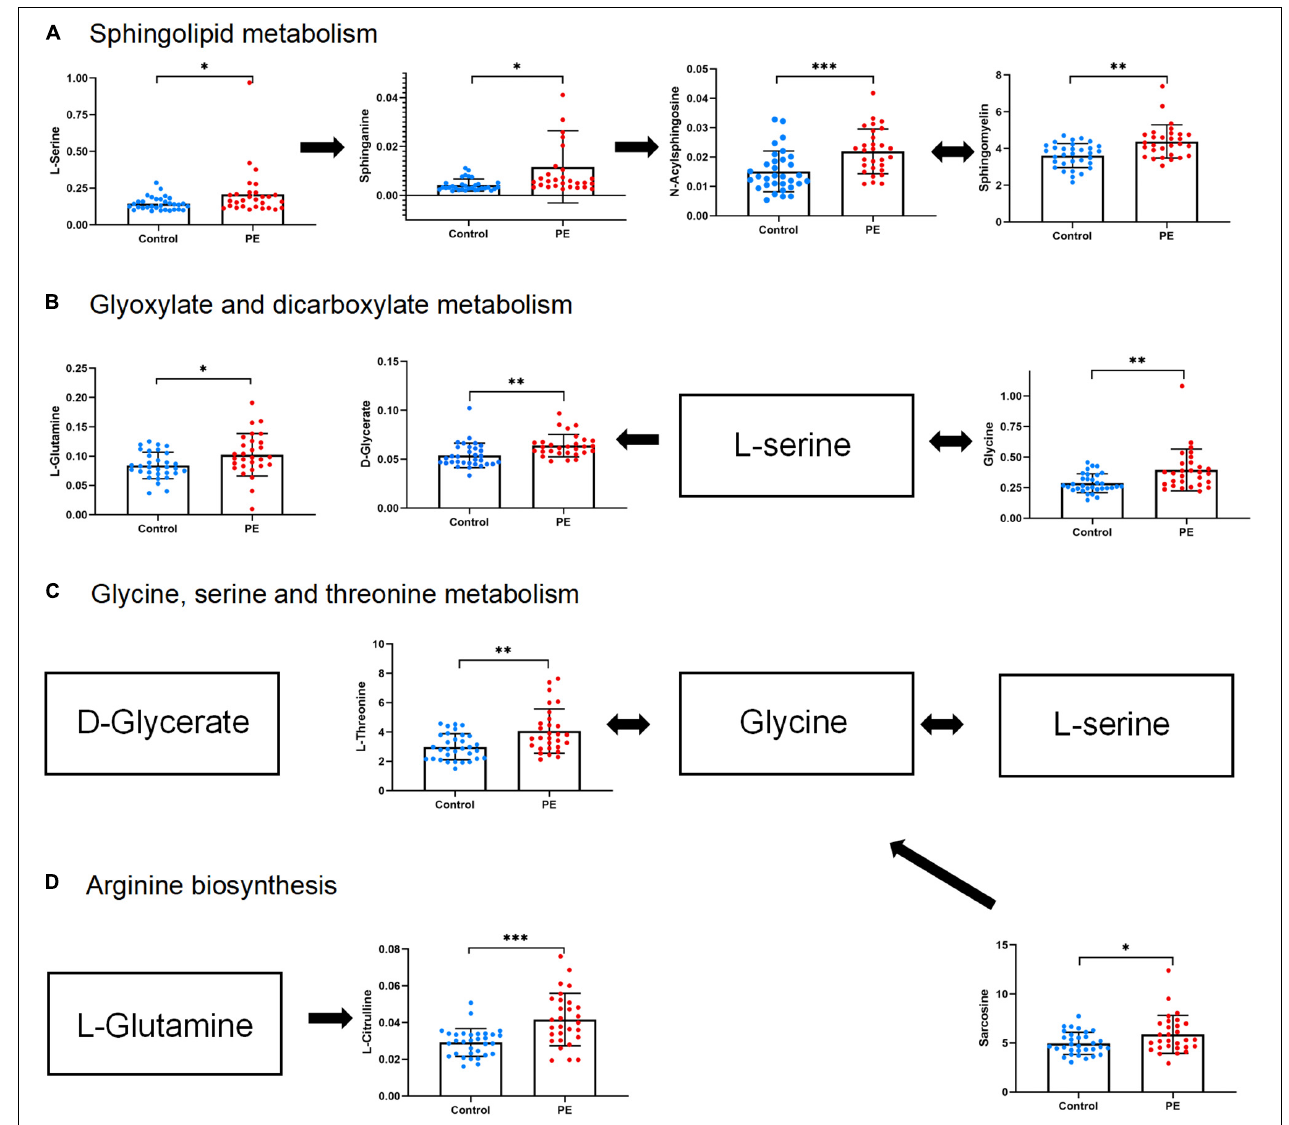
FIGURE 5 | Abundance of differential metabolites in four metabolic pathways related to PE neonates. (A) Sphingolipid metabolism. (B) Glyoxylate and dicarboxylate metabolism. (C) Glycine, serine, and threonine metabolism. (D) Arginine biosynthesis. Mean standard deviation and p -values are shown in the graph. ∗ represents p < 0.05, ∗∗ represents p < 0.01, ∗∗∗ represents p <